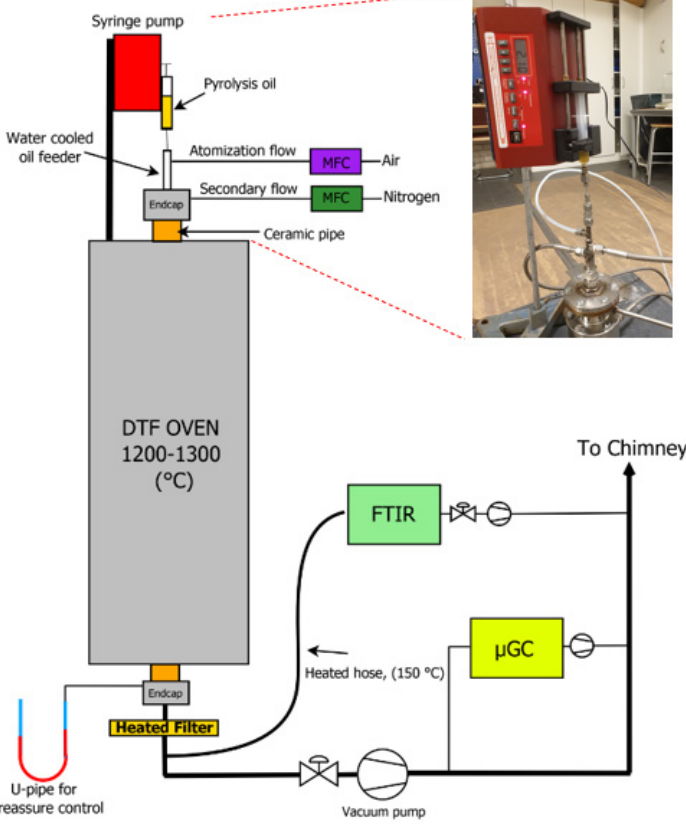
Figure 6. Schematics of the experimental setup used for gasification experiments in the DTF.